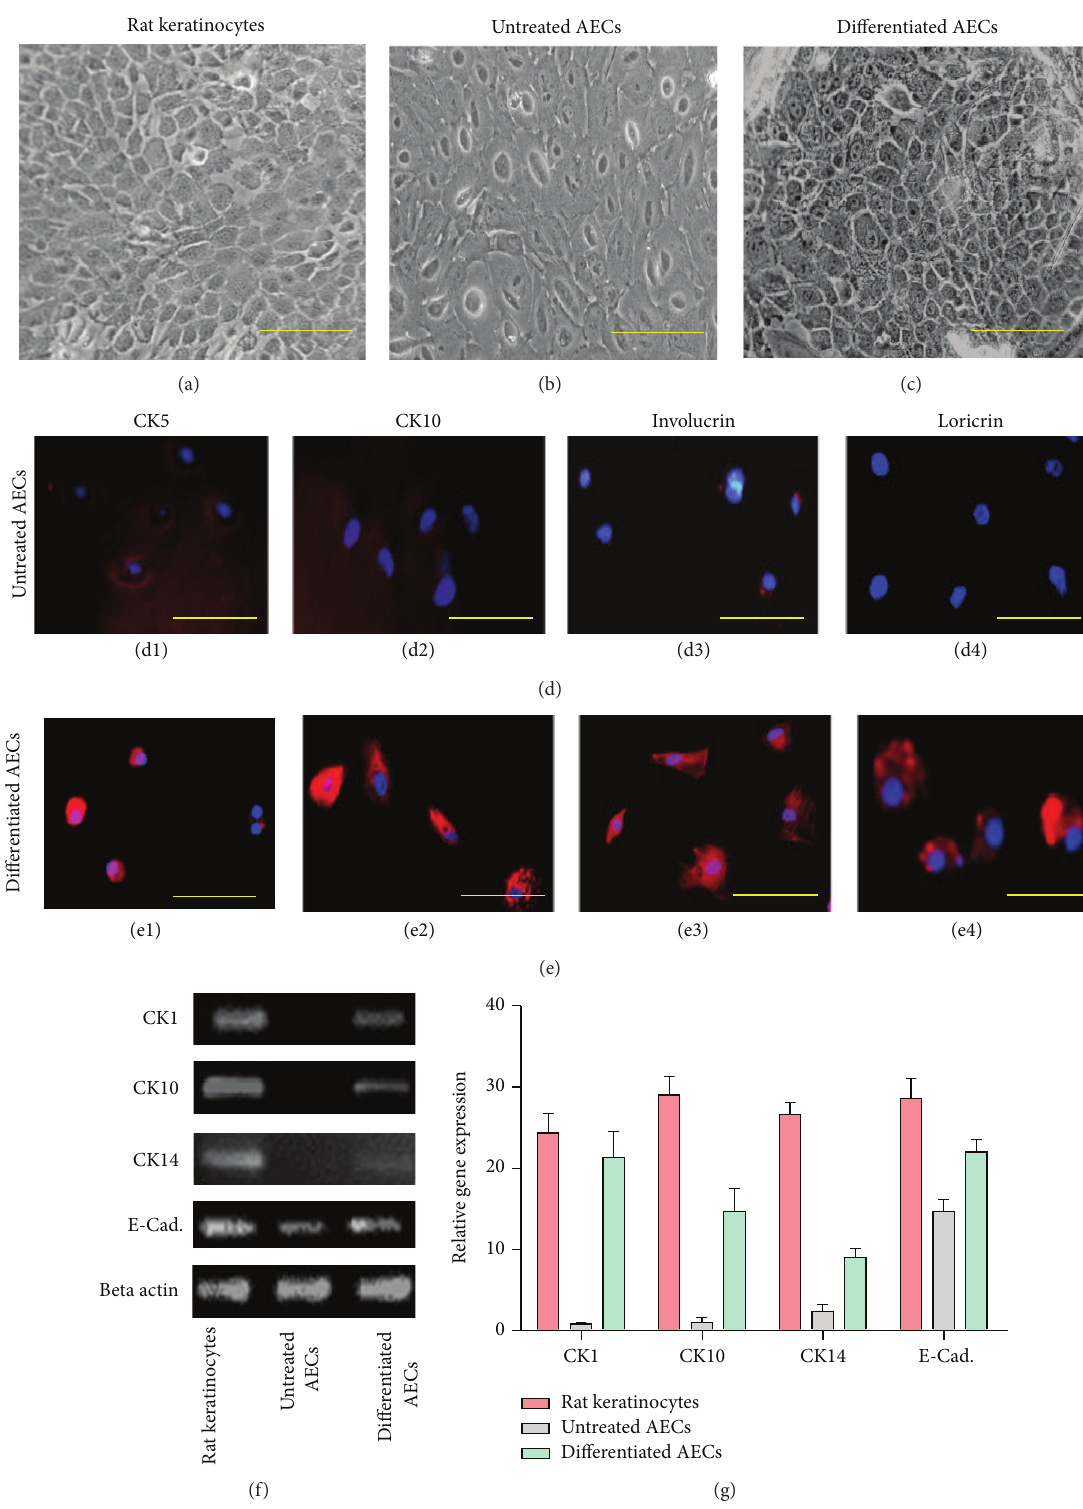
Figure 4: Differentiation potential of amniotic membrane epithelial cells into keratinocyte-like cells. Cytomorphology of (a) positive control, (b) untreated AECs, and (c) induced keratinocytes-like cells. Immunofluorescence staining with CK5, CK10, involucrin, and loricrin in ((d1)– (d4)) untreated AECs and in ((e1)–(e4)) induced cells. Expression of mRNA of CK1, CK10, CK14, and E-Cadherin in positive control